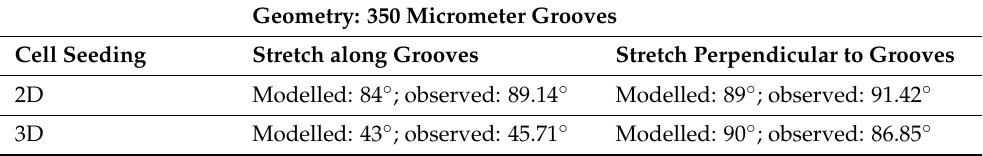
Table 4. Theoretical and measured alignment angles. The angles here are expressed in degrees and indicate the orientation of the cells relative to the applied cyclic mechanical stretch (0 ◦ = aligned with stretch, 90 ◦ = perpendicular to